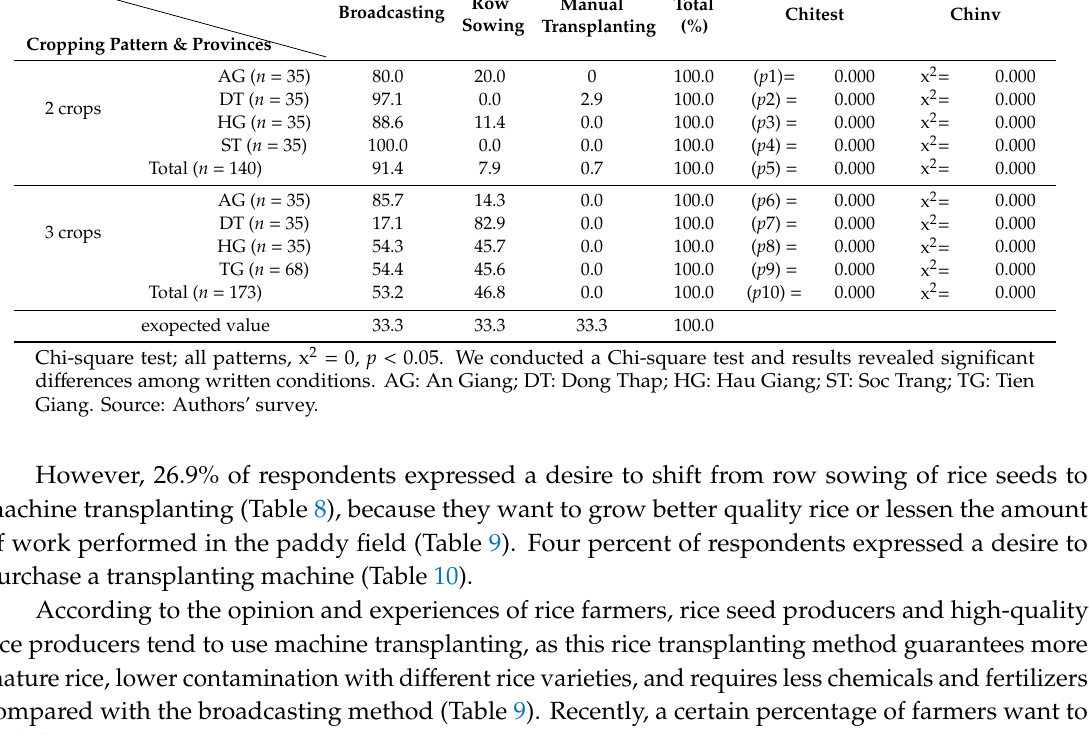
Cropping Pattern &